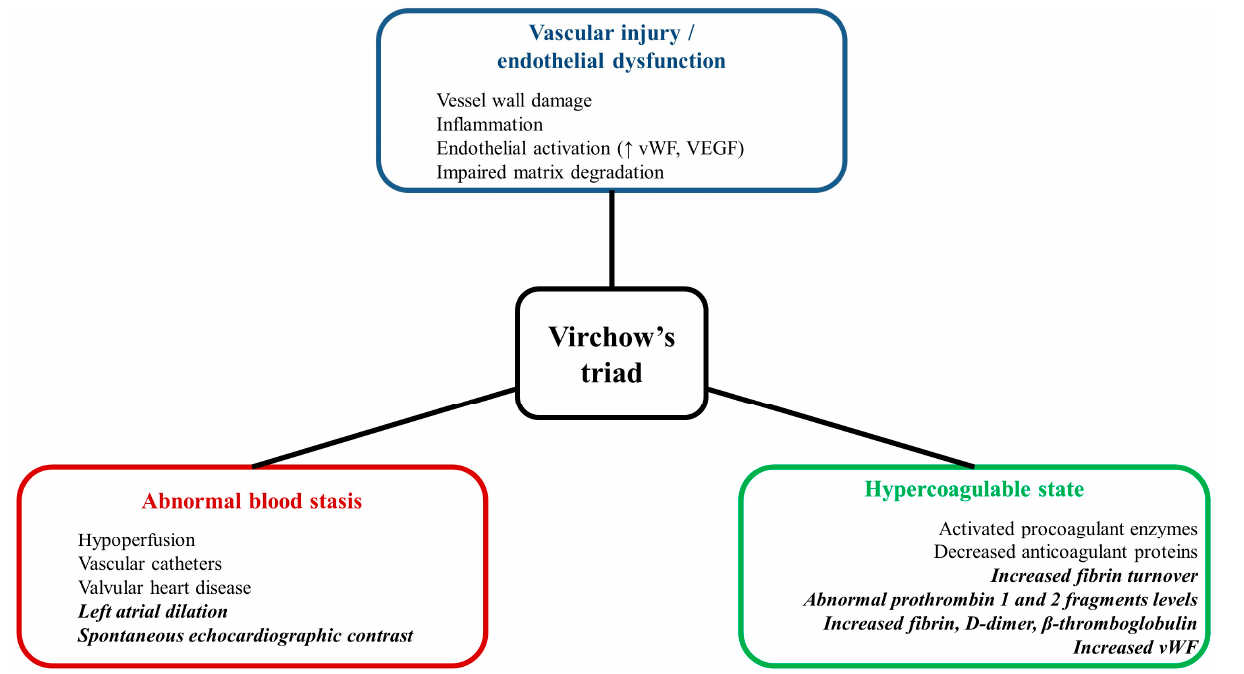
Figure 1. Virchow’s criteria as risk factors for ischemic stroke in the presence and absence of atrial fibrillation. Factors specific for the presence of atrial fibrillation are written in bold font. VEGF—vascular endothelial growth factor; vWF—von Willebrand factor. ↑ indicates an increase in biomarkers levels.